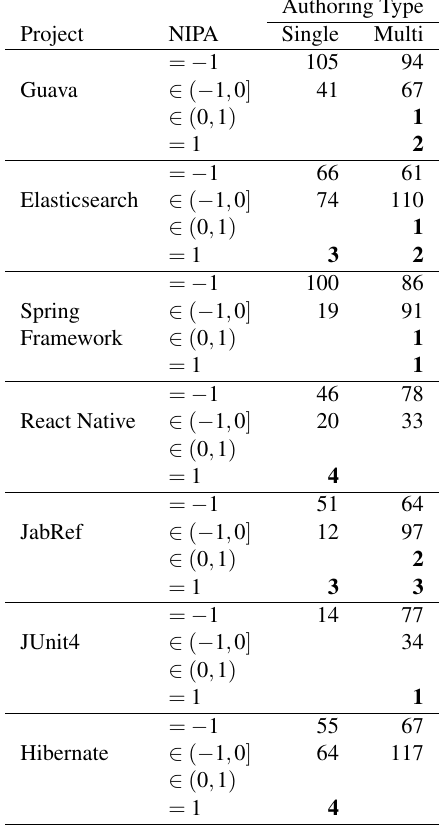
Table 4. Number of violations according to their NIPA values and authoring